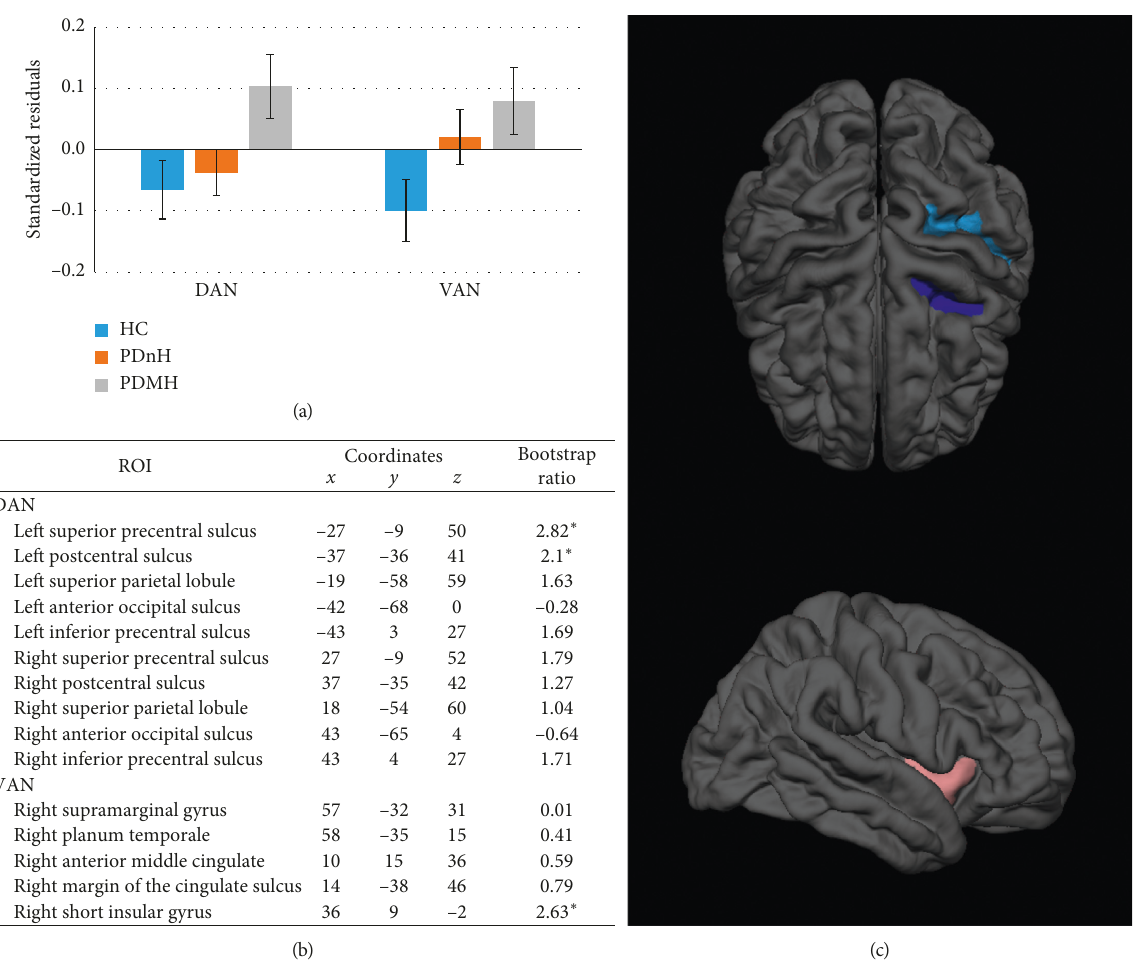
Figure 1: Group difference in cortical thickness. (a) Linear contrasts for each PLS network analysis. (b) Central MNI coordinates of the FreeSurfer parcellations and bootstrap ratios (BSRs) for all ROIs within the DAN and VAN. Asterisks indicate the most salient ROIs (BSR 2) contributing to each pattern. (c) Most salient ROIs in the DAN (dark blue lobule) and VAN (orange right insula). DMN is not depicted as no significant latent variable was (cid:31) ≥